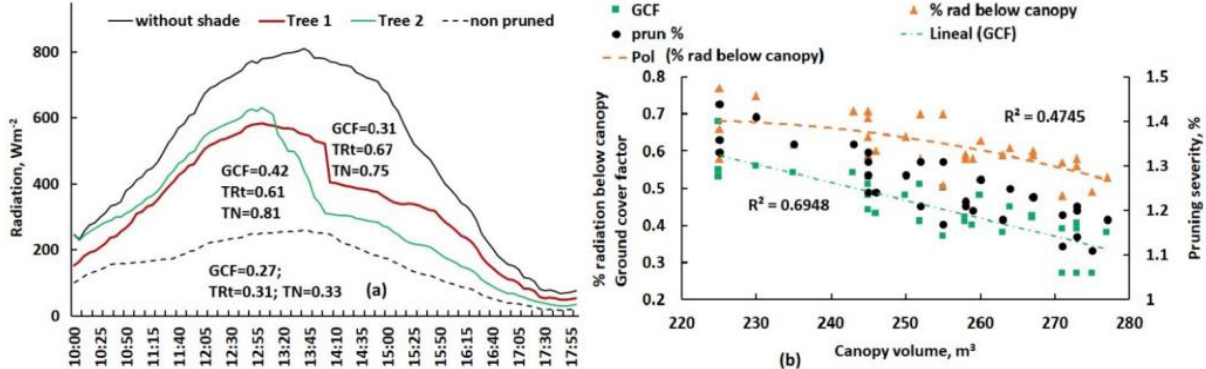
Figure 15. Radiation ( a ) measured on the 22 May of 2021 for two pruned mature trees, and ( b ) its correlation against canopy volume of two pruned trees.